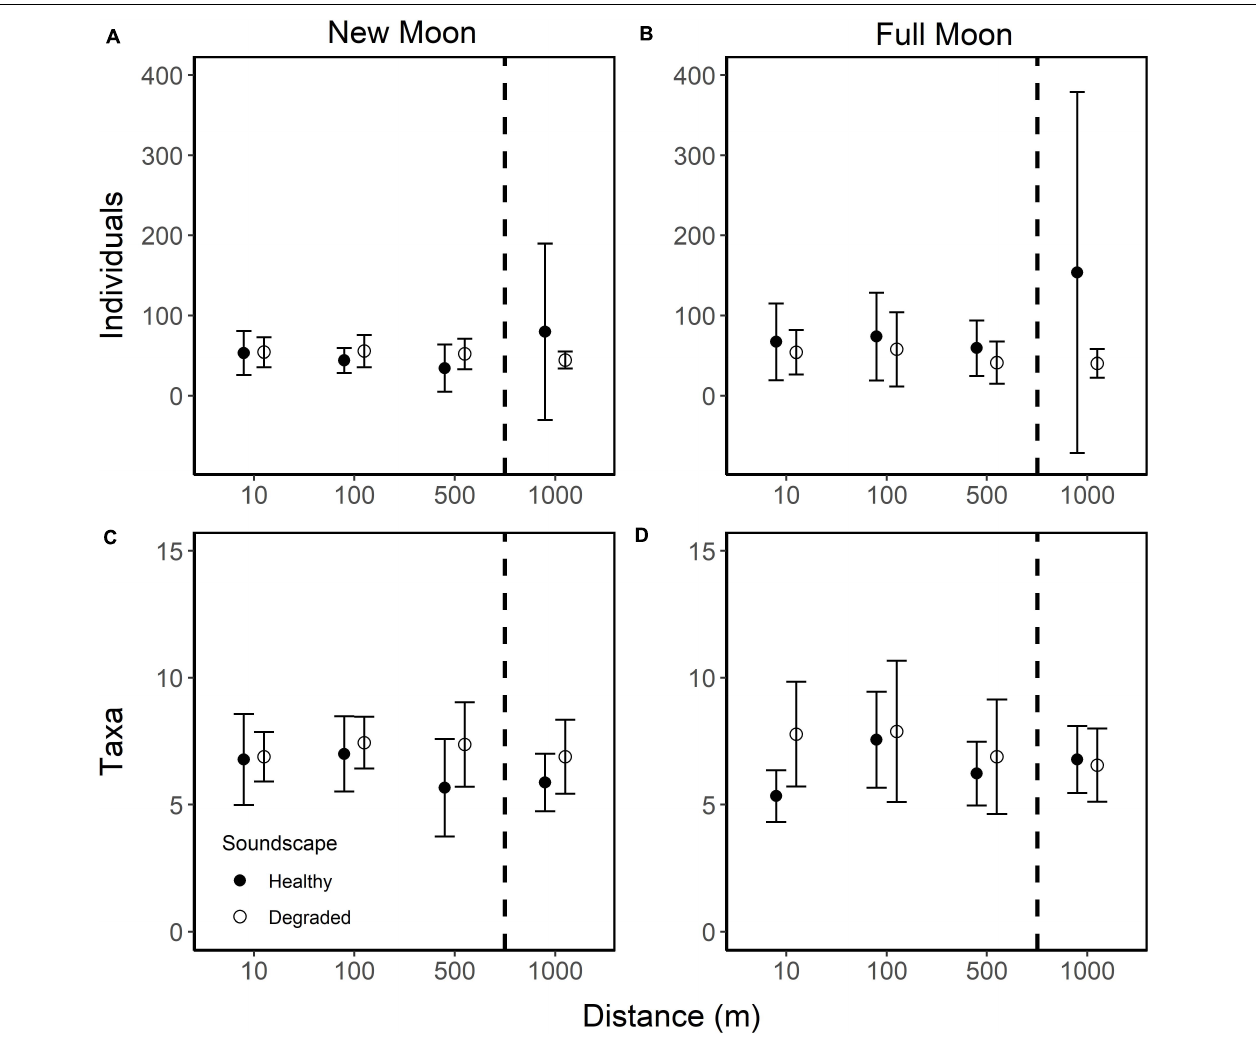
FIGURE 5 | Mean number of individual larvae (A,B) and taxa (C,D) per collector for collectors deployed 10, 100, 500, and 1,000 m from broadcasted healthy (closed circle) and degraded (open circle) soundscapes during new (A,C) and full moon (B,D) phases. All error bars are 95% confidence intervals. Dashed lines indicate collectors that lie outside the detectable sound range (1,000